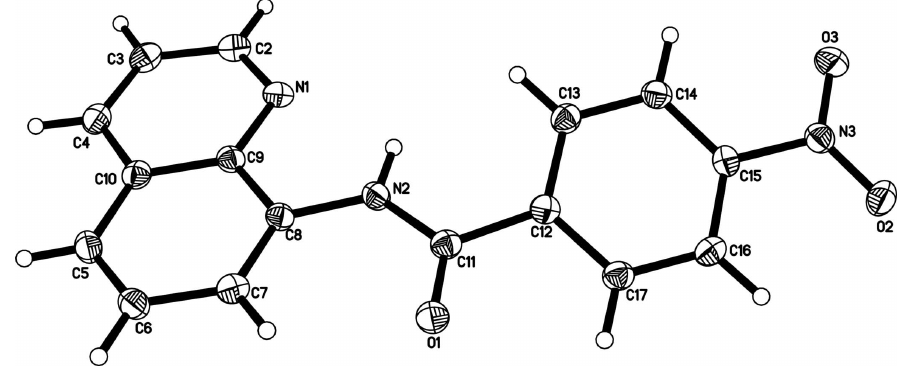
Figure 1 The molecular structure of the title compound, showing 50% probability displacement ellipsoids and the atomic